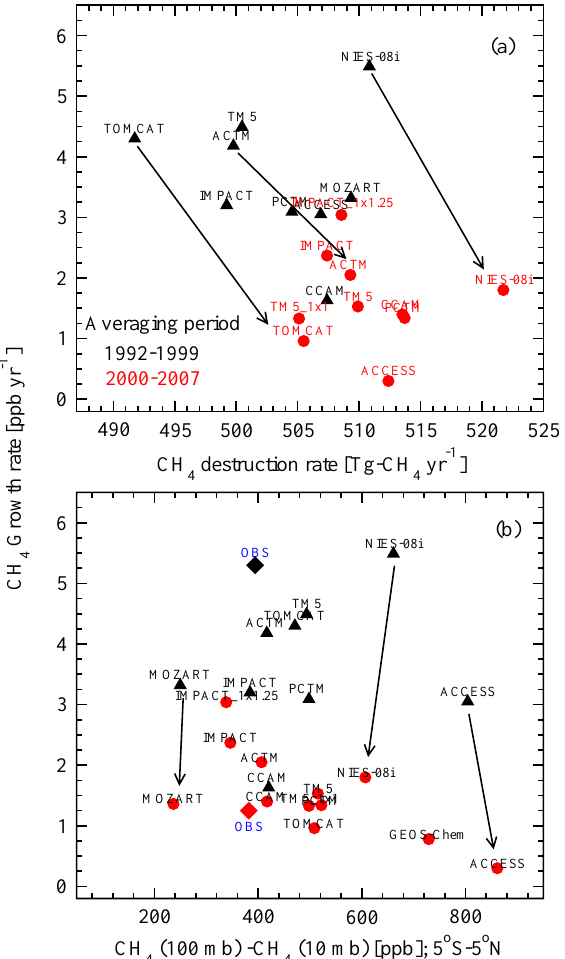
Fig. 11. Relationships of global loss rates for different models (CH 4 EXTRA) with their simulated growth rates at surface sites (a) , and the modeled vertical gradients in the lower stratosphere (100–10mb layer; b ) with growth rate. ACTM OH and GEOS- Chem DOH are excluded from this analysis as those models used different OH fields.